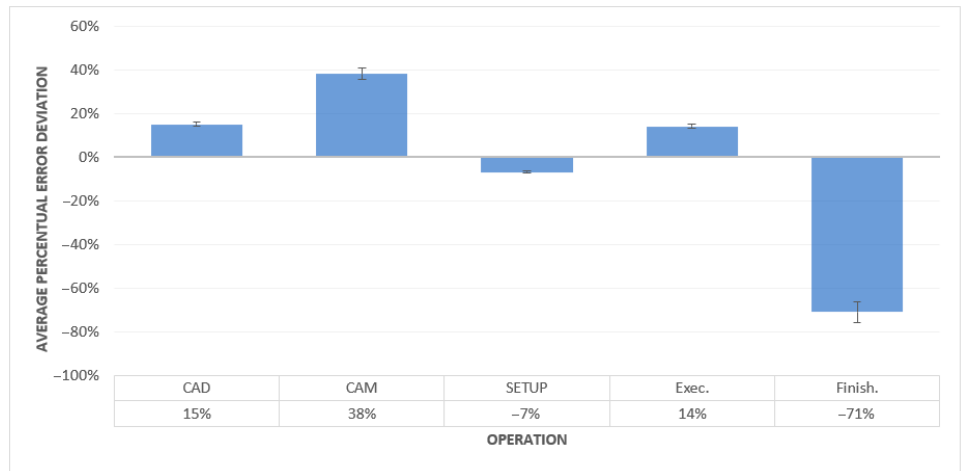
Figure 10. Average percentual deviation for each part production step.